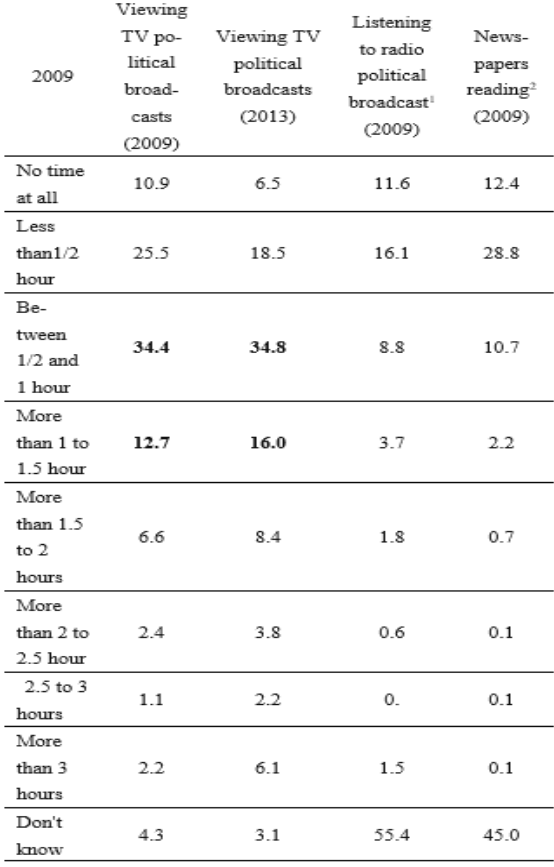
Table 1. Time for newspapers, radio